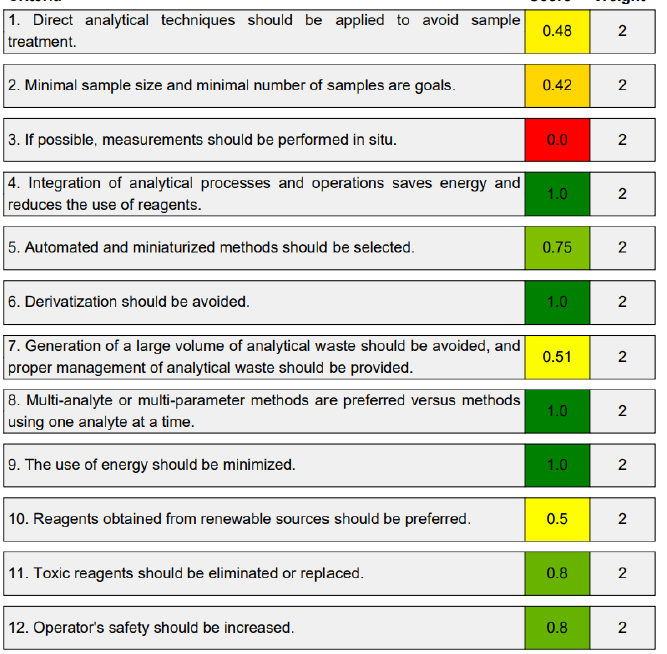
Figure 5. AGREE pictograms of the proposed method.